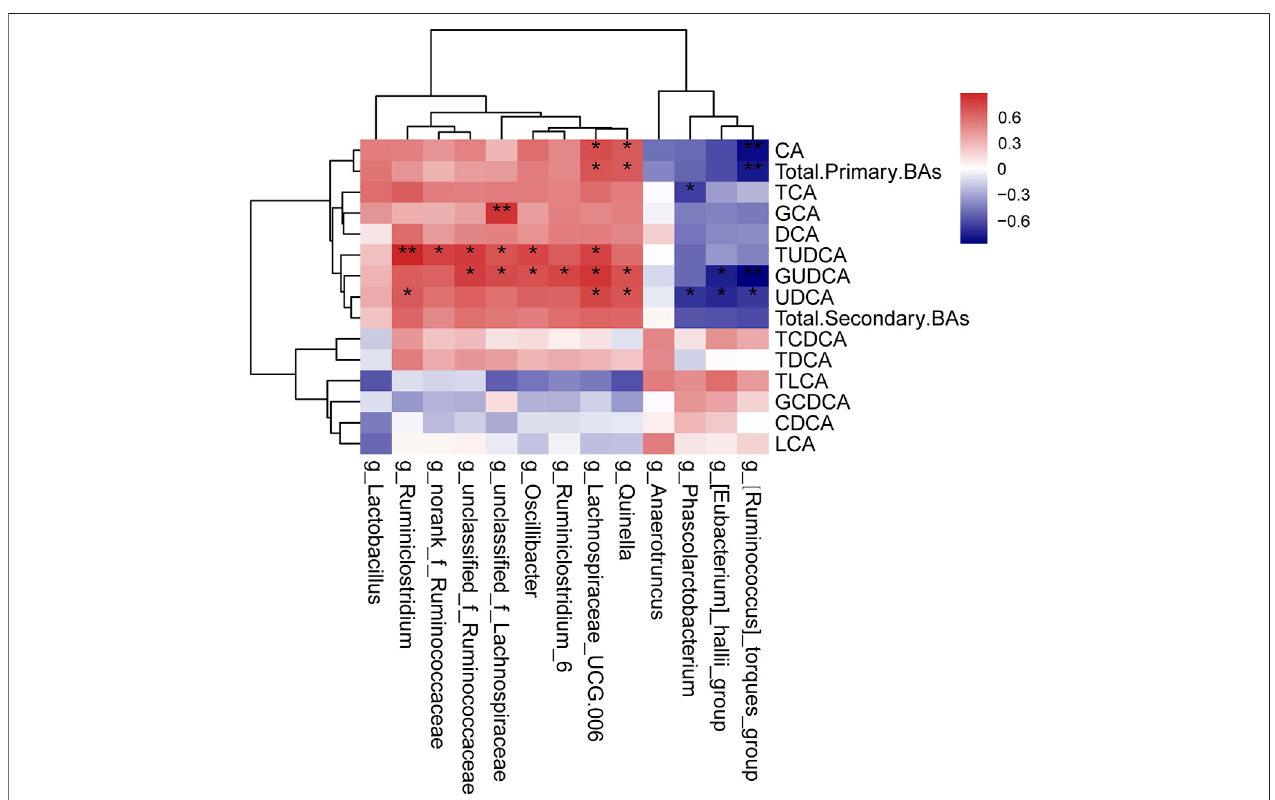
FIGURE7| CorrelationanalysisofthegutmicrobiomeandserumBAs.TheresultsofSpearman ’ scorrelationbetween13differentialgenera(METvs.DM)andBAs (MET vs. DM) were presented as a heatmap. * p < 0.05, ** p < 0.01 denoted statistical signi fi cance between bacterial taxa and BAs.